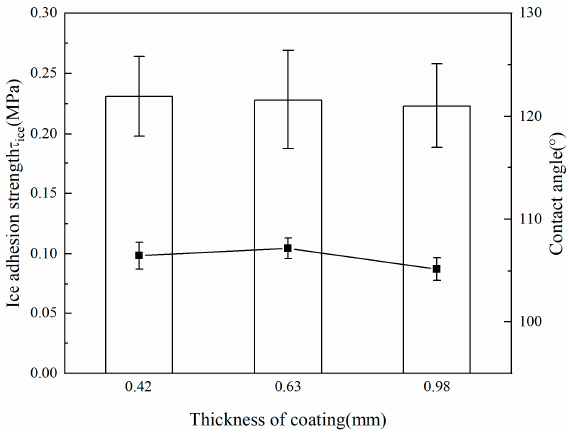
Figure 16. Adhesion strength and contact angle for coatings with different thicknesses.